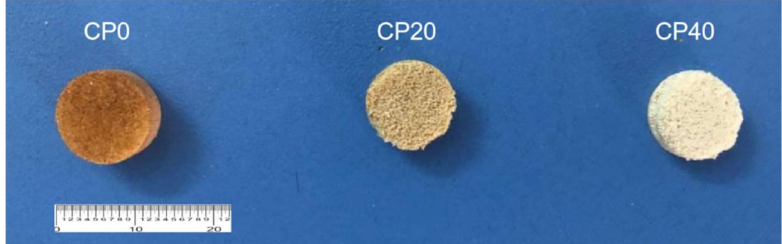
Figure 1. Digital photos of composite PEEK material samples (CP0, CP20, and CP40).